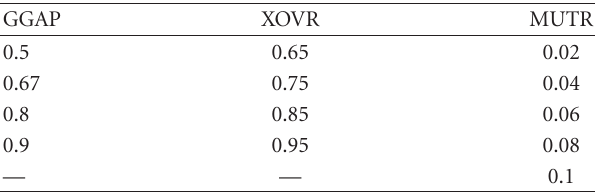
Table 1: Range of investigated genetic algorithm parameters. Table 2: Genetic algorithms parameters.